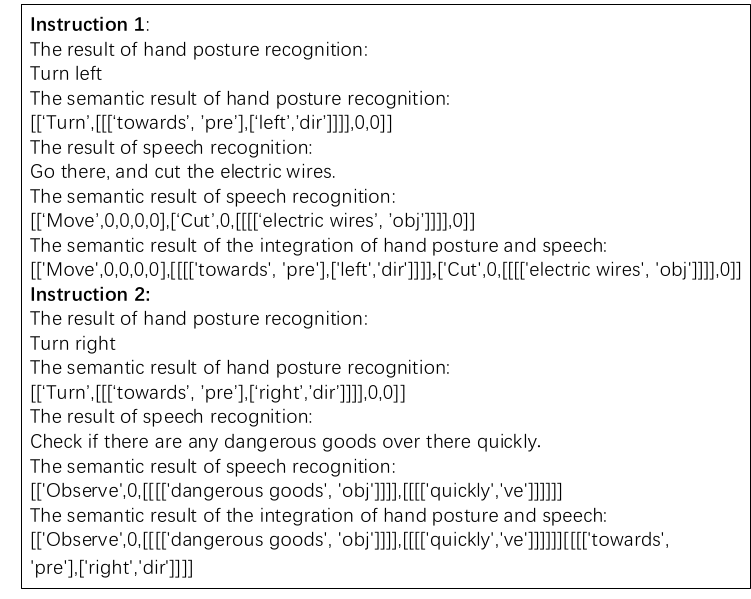
Figure 18. Results of the integration of deictic hand posture and speech instructions when the demonstrative word was a pronoun.